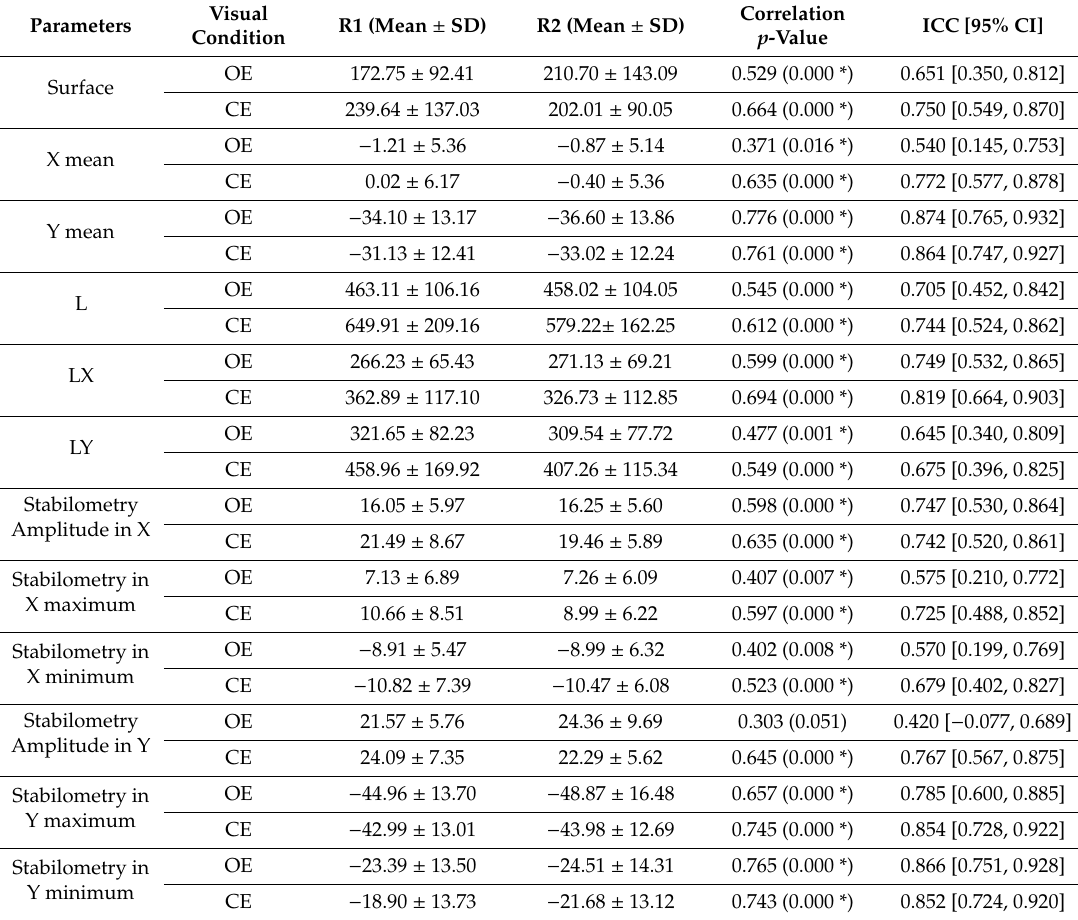
Table 3. Stabilometric results of stabilometric variables in static